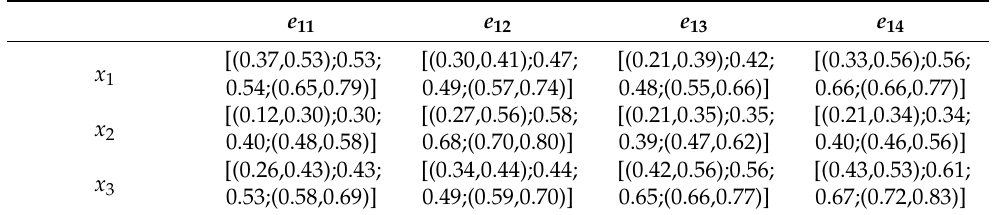
Table A14. The influencing factors of B 1 in the whole time period belong to the comprehensive evaluation value of different risks.